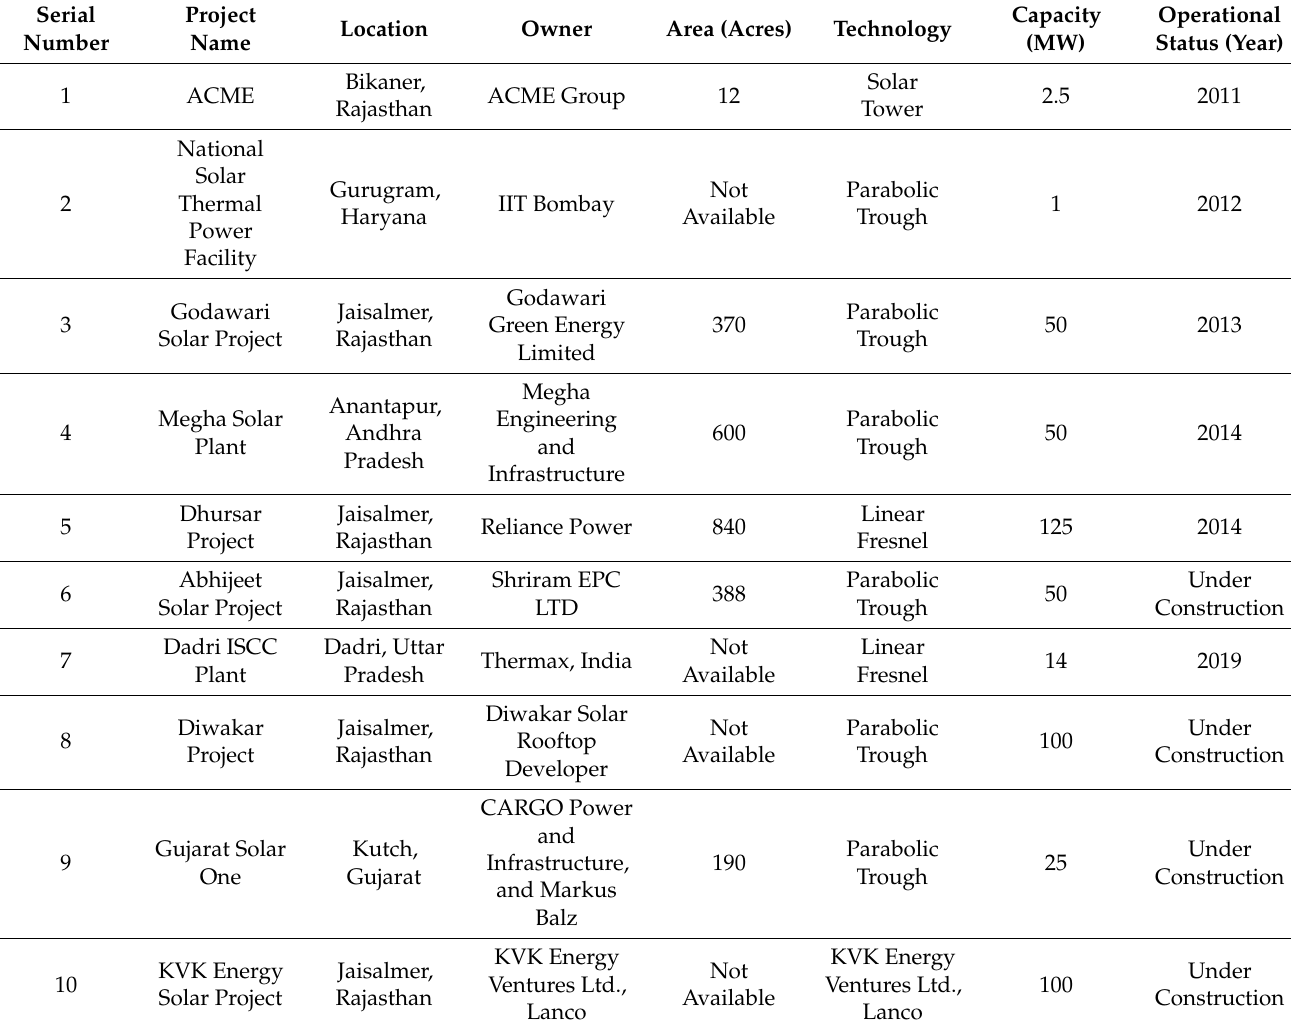
Table 6. Details of developed and under-developed CSP projects in India